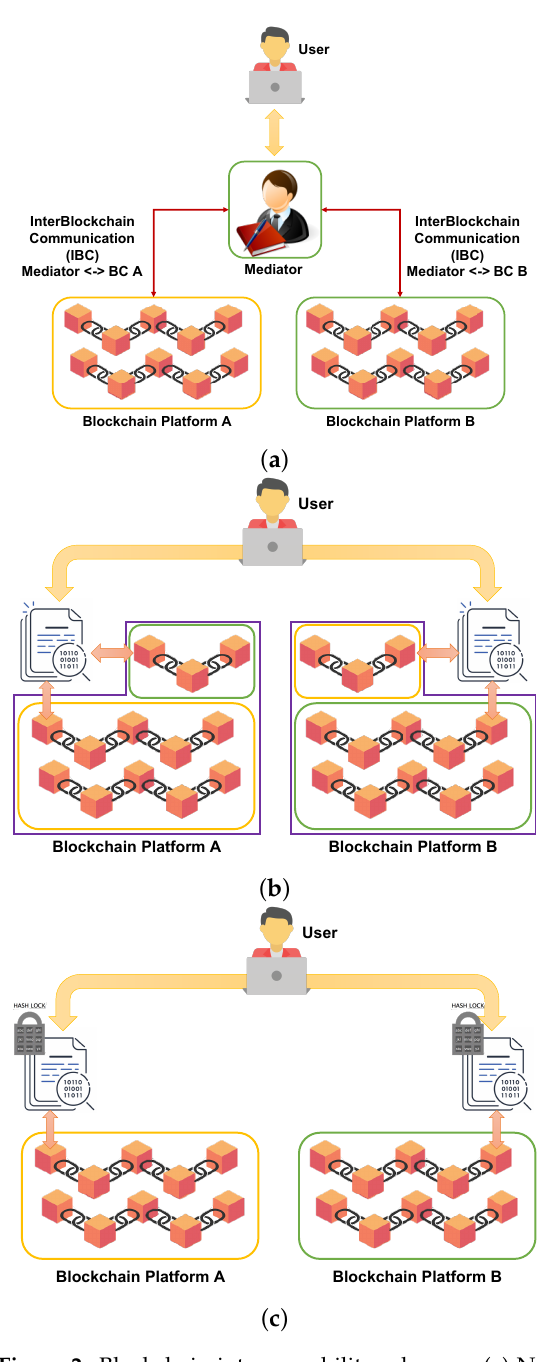
Figure 2. Blockchain interoperability schemes. ( a ) Notary scheme solution. ( b ) Sidechain-based approach. ( c ) Hash-locking smart contracts for asset transfer between